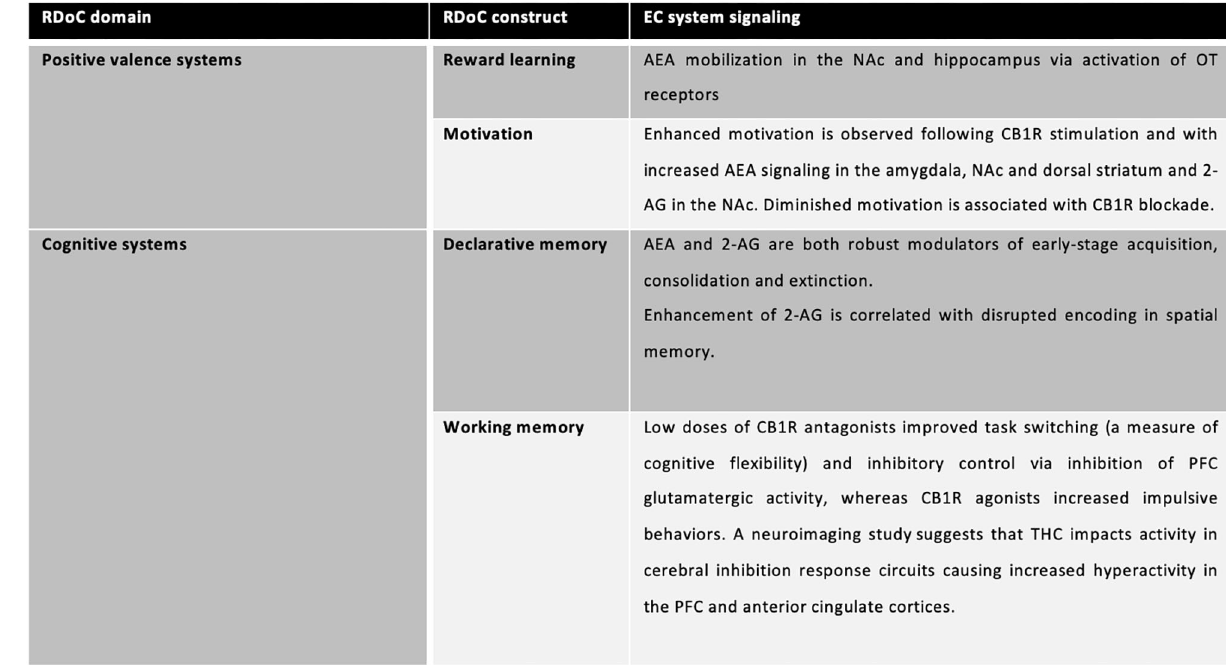
FIGURE 2 | EC systems signaling involved in specific RDoC domains and